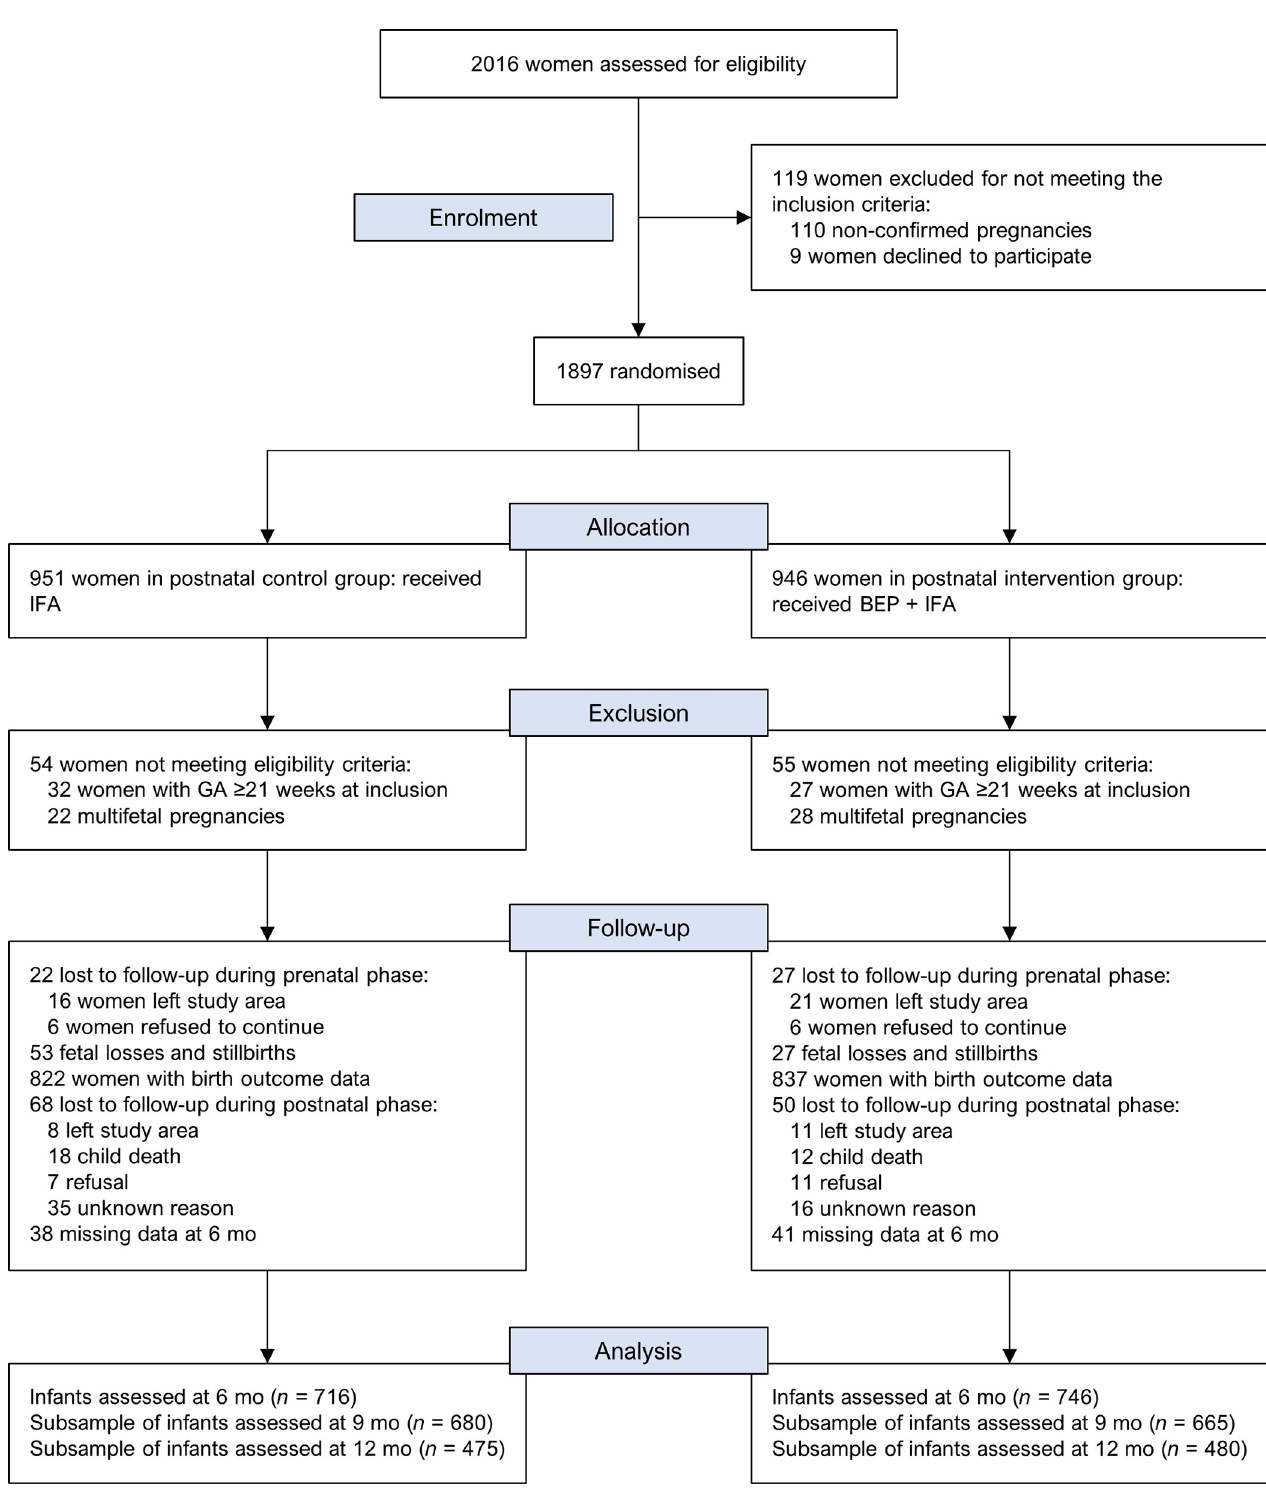
Fig 1. Trial flowchart of the MISAME-III study by the postnatal intervention arms. BEP, balanced energy–protein supplementation; GA, gestational age; IFA, iron–folic acid tablets; MISAME, MIcronutriments pour la SAnte´ de la M è re et de l’Enfant.